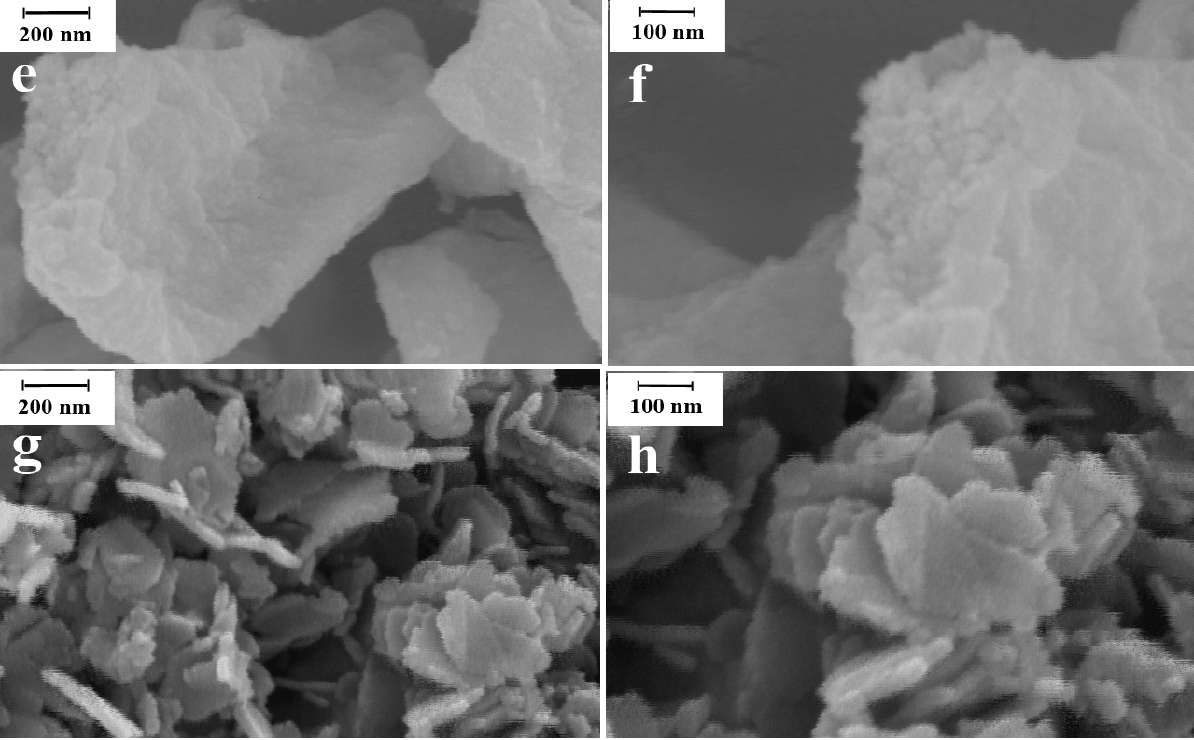
O nanoparticles calcined at 500 °C, 2h, (g and h) 600 °C, 2 3